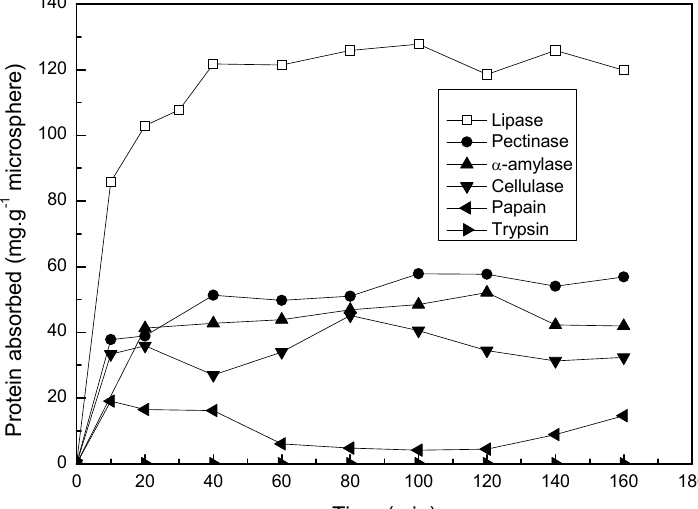
Figure 6. Dynamic curves of proteins adsorption on the polyamine microsphere (pH 7.0, 25